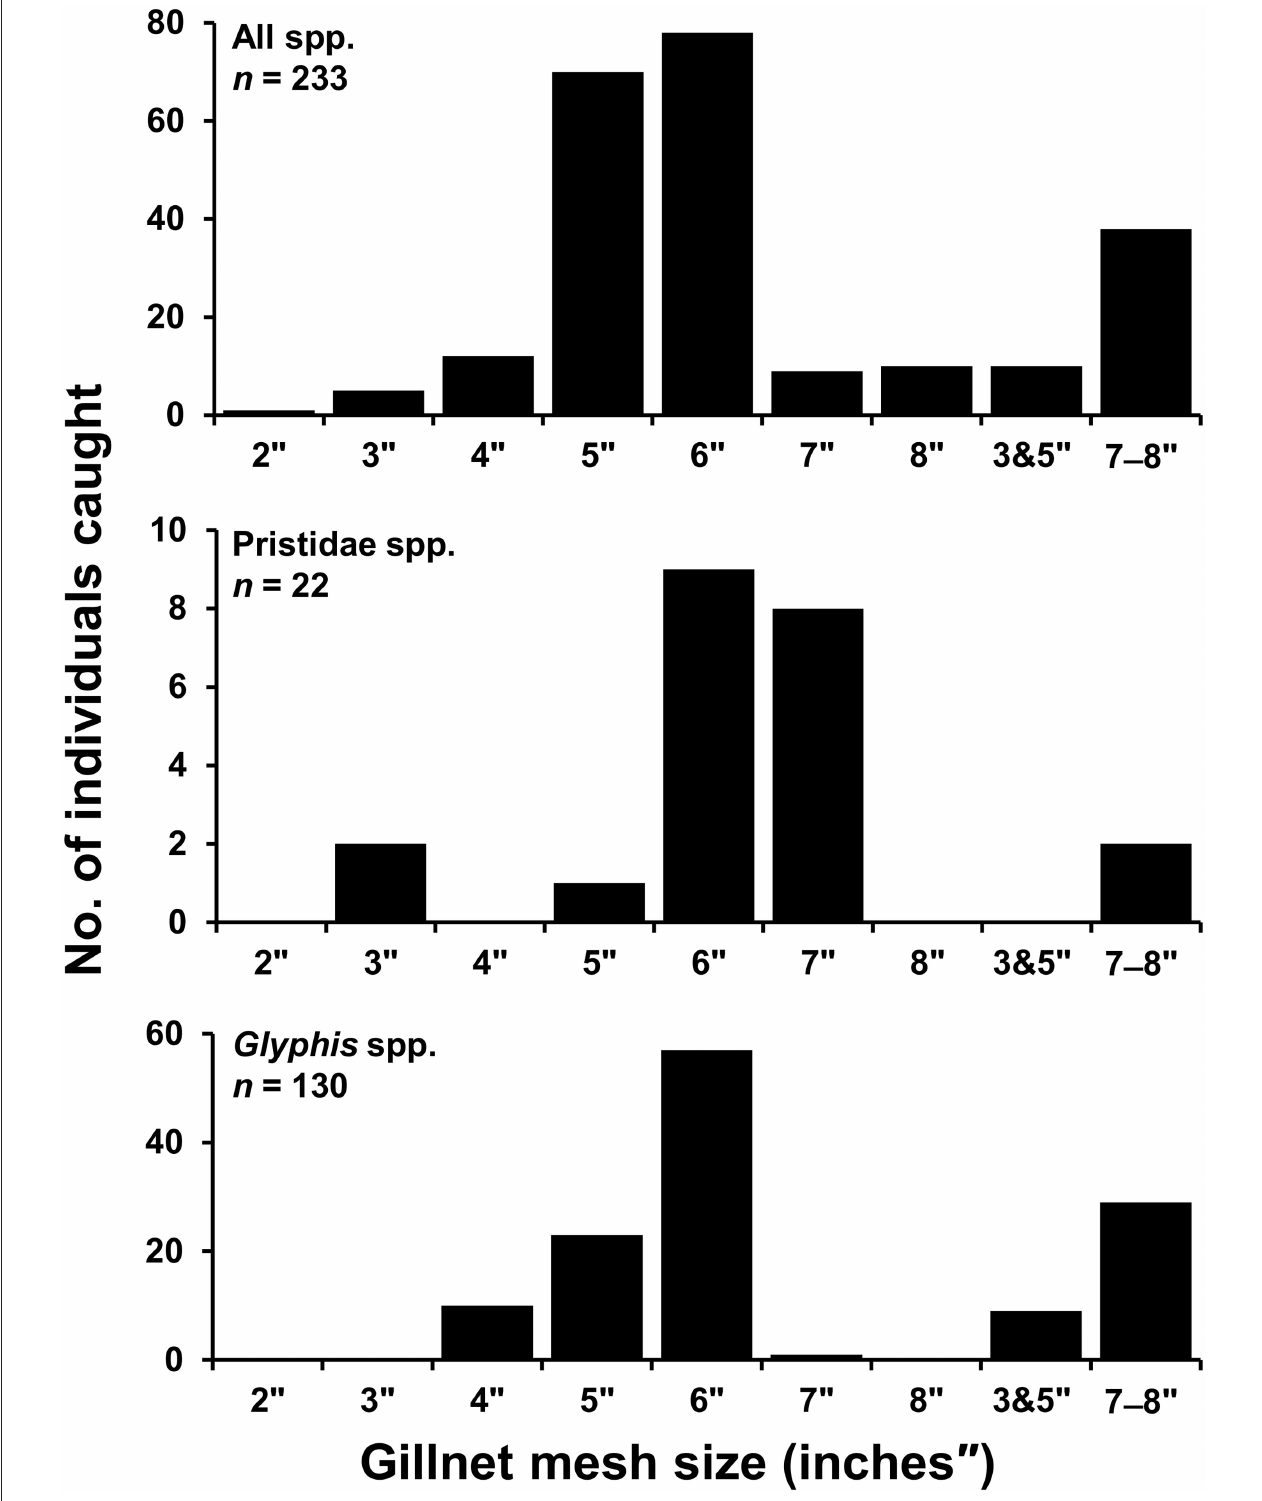
FIGURE 5 | Number of specimens caught where records of gillnet mesh size (inches) was reported in small-scale fisheries of Papua New Guinea. All species (Top) , Pristidae spp. (Middle) , Glyphis spp. (Bottom) . 3 ′′ and 5 ′′ refers to mesh sizes overlaid in a single net, 7 ′′ -8 ′′ were records reported from either 7 ′′ or 8 ′′ nets though not discernible per specimen